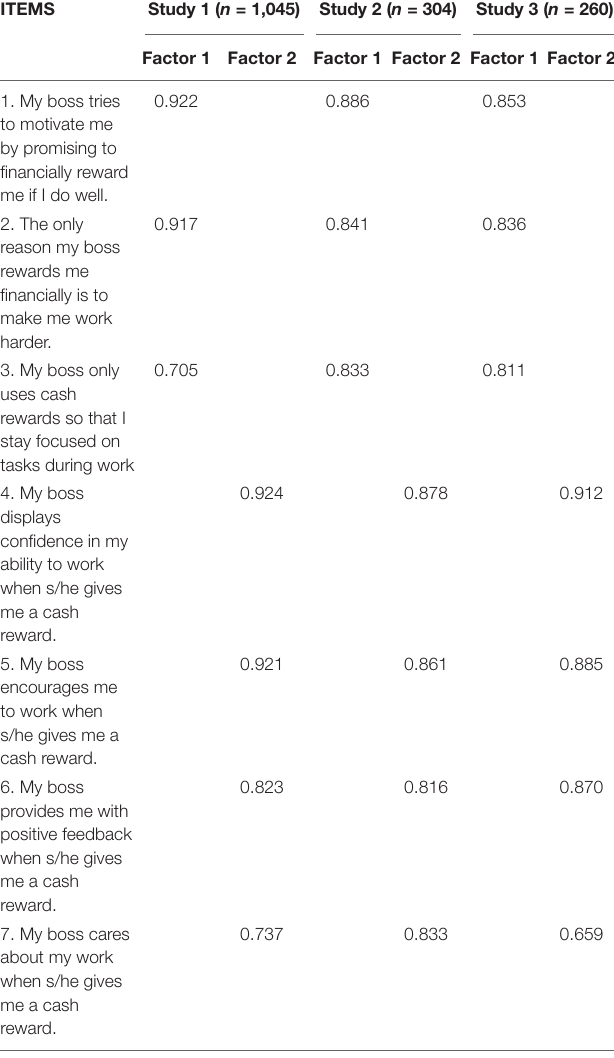
TABLE 5 | Correlations and reliability coefficients along the diagonal for the variables in Study 1 ( N = 1,045).